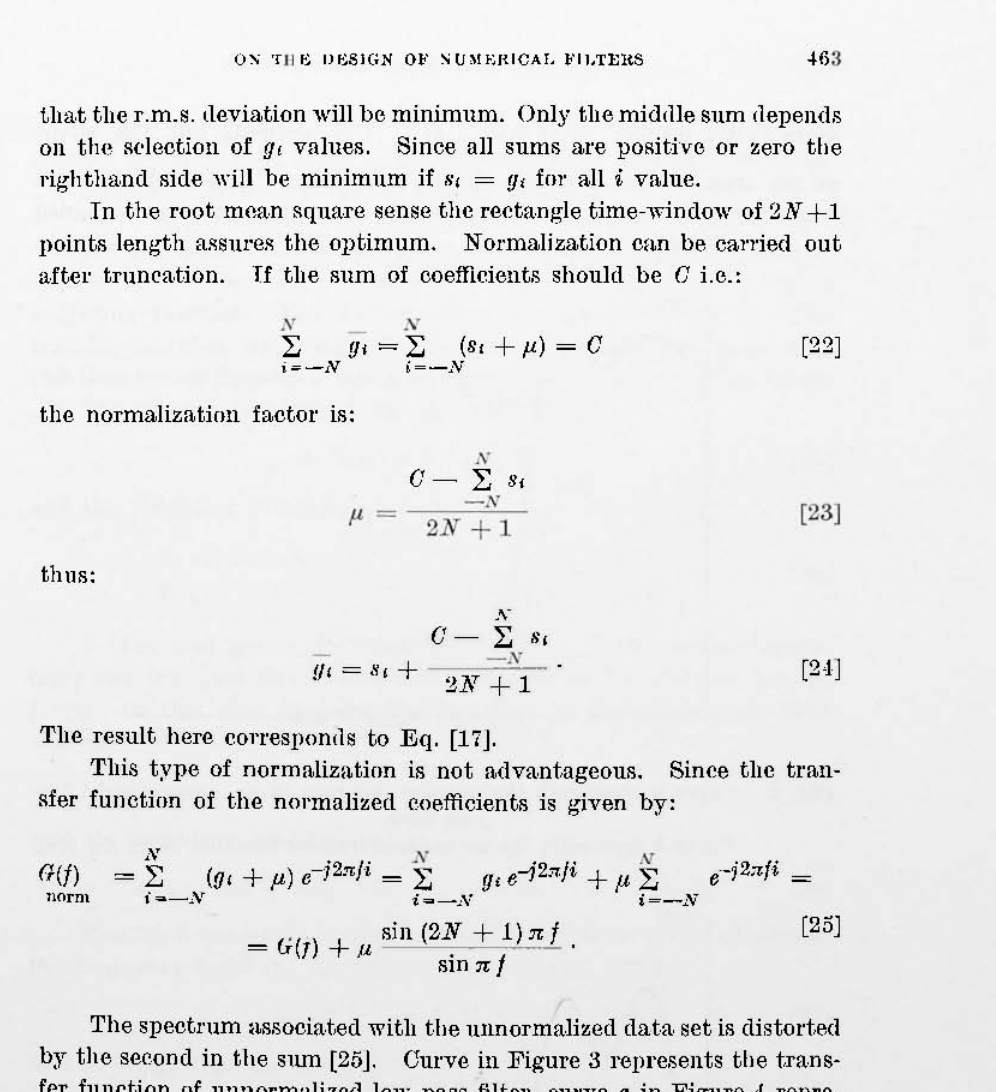
Curve in Figurc:3 l'epI'csents the trans fcr function of unnormalized 1m" pass filteI', curve a in Figure 4. repre sent.'1 the normalizing function, curve b in Figure 4 ifl thc normalized transfcI'